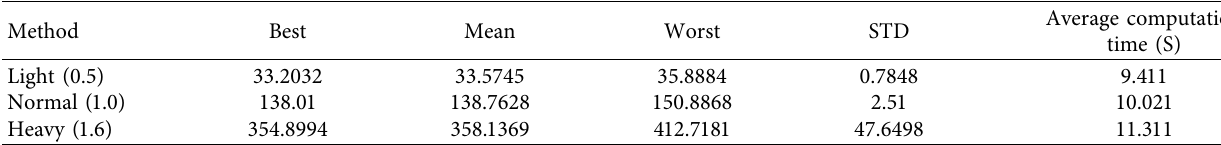
Figure 14: Convergence characteristics for nominal load conditions of the proposed HBO and other algorithms. Table 7: Statistical results of 50 independent